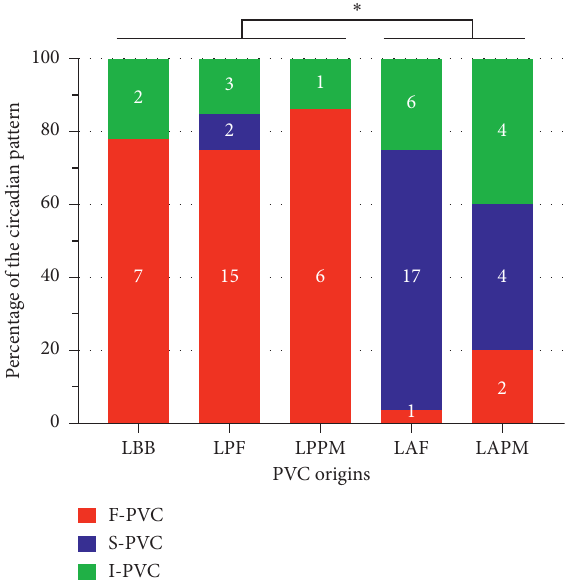
All patients with ASV or LVOT PVCs Excluding patients with PVC Figure 5: ROC curve documenting the ability of diurnal/nocturnal PVC burden ratio to differentiate LVOTand ASV origins. ROC curves plotting the true-positive rate (sensitivity) versus false-positive rate (1 − specificity) documenting the ability of diurnal/nocturnal burden ratio to differentiate LVOTand ASV origins in all patients (blue curve, AUC � 0.827) and in patients without PVC recurrence after ablation (red curve, AUC � 0.910). The ROC curve in combination with Youden’s index supports a diurnal/nocturnal burden ratio of 0.92 as a cutoff. ASV, aortic sinus of Valsalva; AUC, area under the curve; LVOT, left ventricular outflow tract; PVC, premature ventricular complexes; ROC, receiver-operating characteristic.